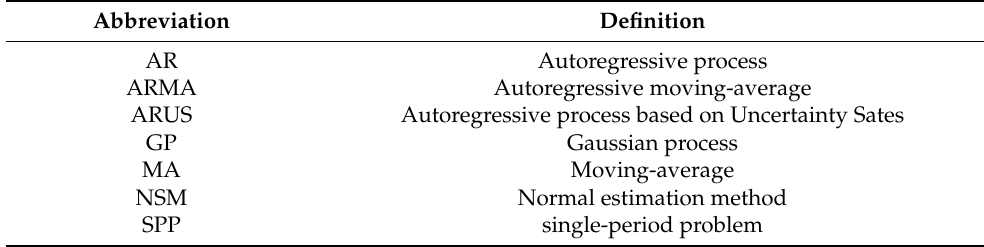
Table 1. List of